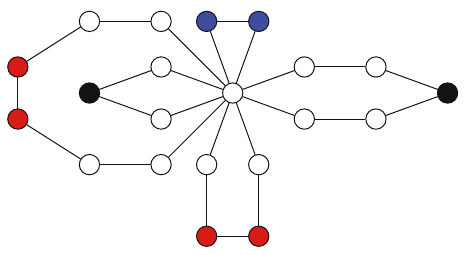
Figure 2: A bouquet of fi ve cycles of the family (cid:2) 2,2,1 containing the cycles C 6 , C 4 , C 7 , C 5 and C 3 .